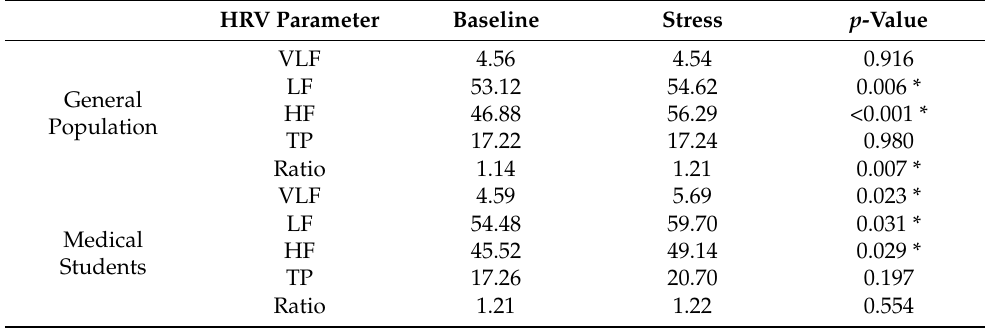
Table 4. Comparison between heart rate variability parameters collected from 3-lead ECG during the baseline (resting) and stress tasks for the general population and medical cohorts (mean values).